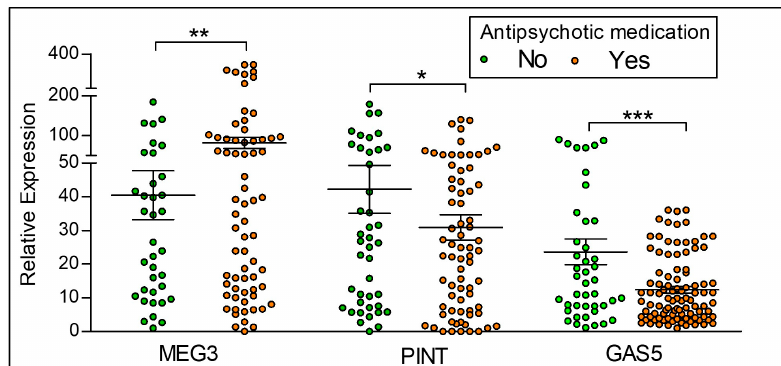
Figure 4. LncRNA expression between controls and participants on antipsychotic medication . Yes